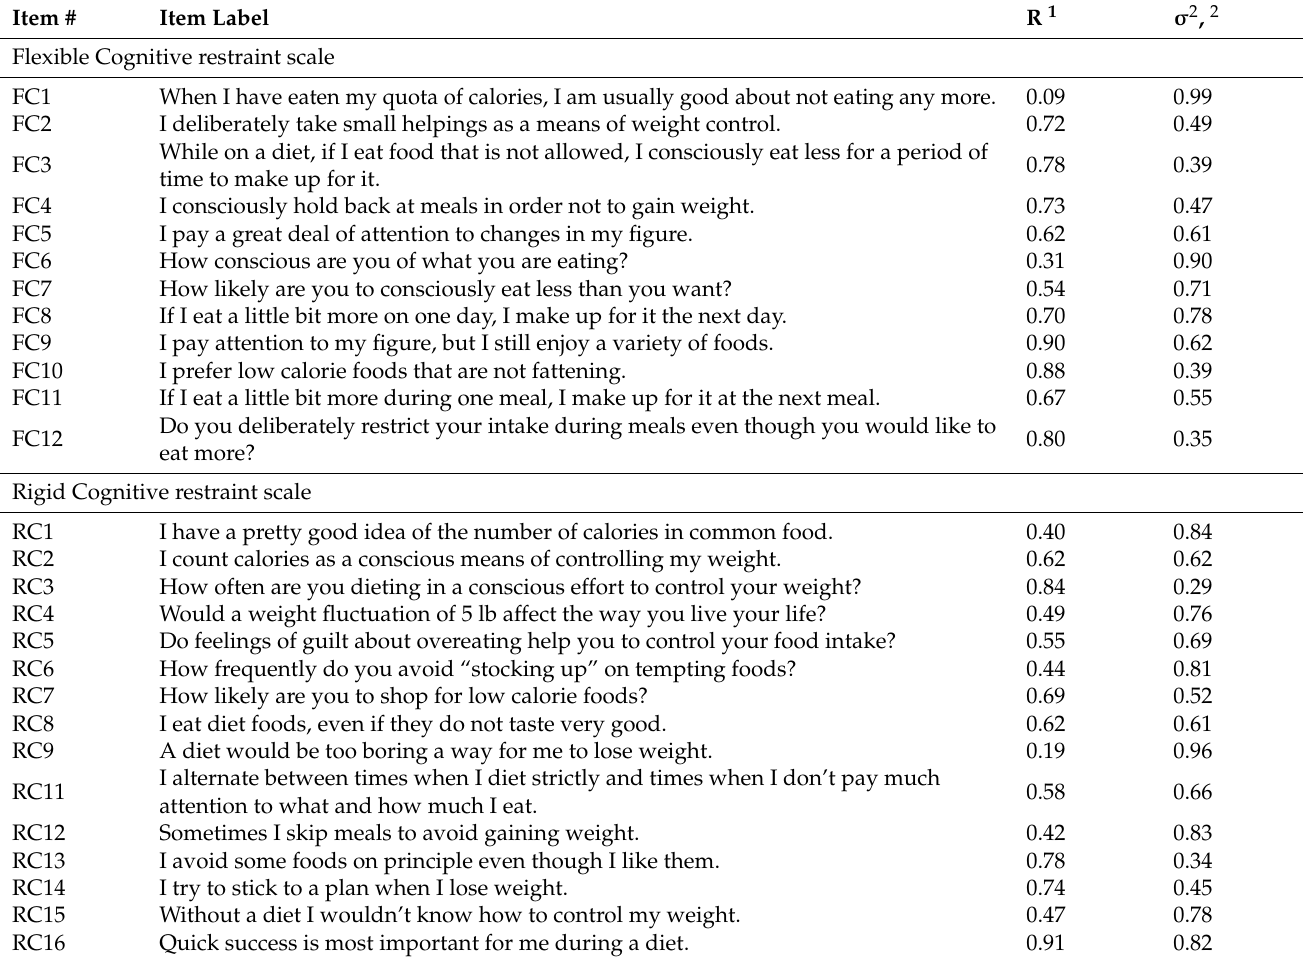
Table 2. Confirmatory factor analysis of the flexible and rigid cognitive restraint (CR) scales among 301 participants of the NutriNet-Sant é study